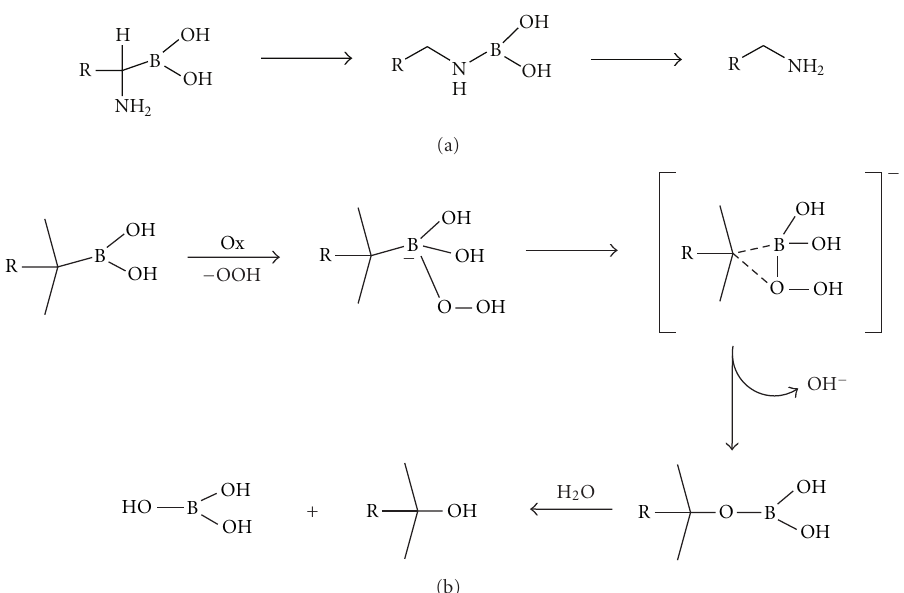
Figure 3: Two possible degradation processes of BTZ in its pharmaceutical solution form (a) degradation pathway of boronic amino acids in presence of water or other nucleophilic agents; (b) oxidative degradation pathway of boronic acids. Table 1: Molecular weight, mass peak, and elemental analysis of BTZ, BTZ1 , and BTZ2 . Comp.